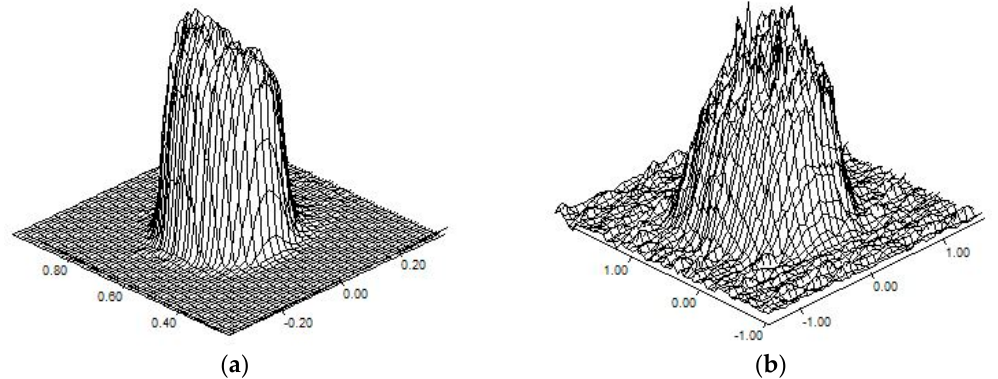
Figure 19. Distribution of transverse optical intensity, for 2.0 kW operating power, at ( a ) focus and ( b ) 18 mm defocused location required for the aimed processing diameter; pictures are not to scale between them.